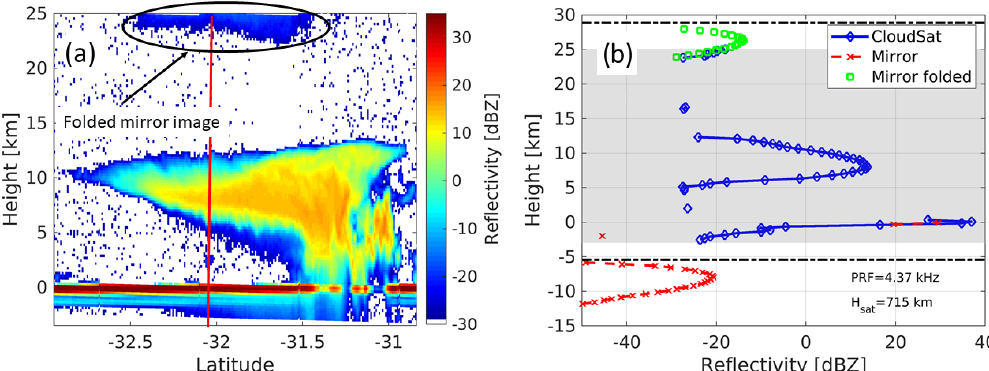
Figure 2. (a) Example of mirror image in CloudSat data produced by a high-reflectivity tropical anvil cloud. The mirror image folds back at heights between 22 and 25km. (b) Exemplification of the folding mechanism for the profile at − 32 ◦ latitude marked with the red line in panel (a) . The dot-dashed black lines delimit the folding ranges; the shaded grey region covers the CloudSat data